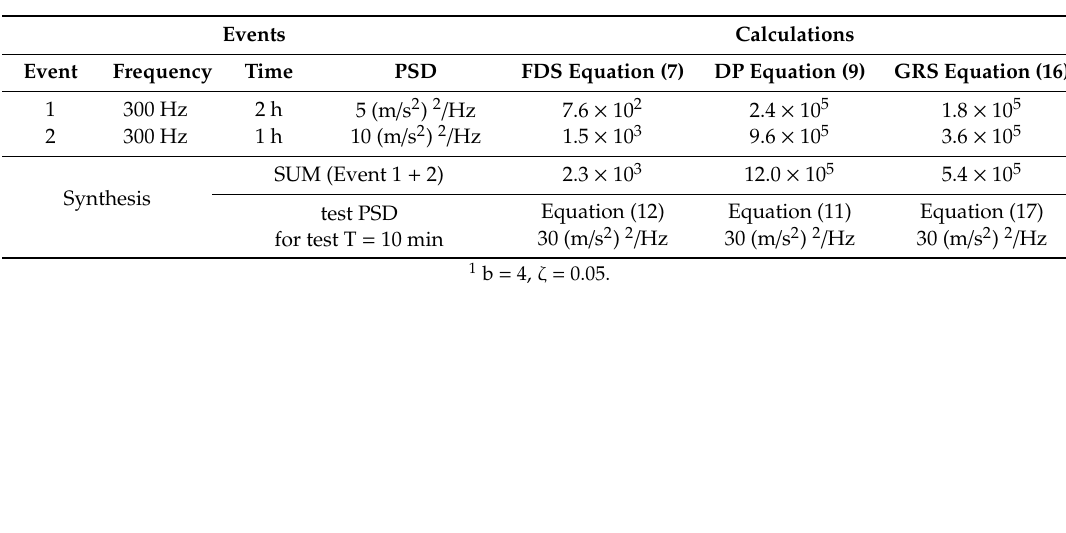
Table 1. PSD synthesis with FDS, damage potential (DP), and GRS 1